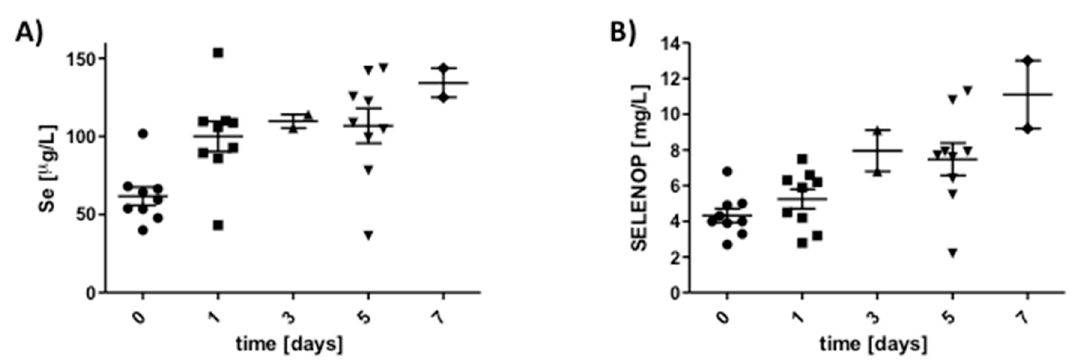
Figure 5. Time-resolved analysis of Se and SELENOP increase upon selenite infusion in cardiac surgery patients enrolled into the SOS-LVAD study. ( A ) Se concentrations increase in most of the cardiac patients undergoing elective heart surgery and selenite infusions (left); patient characteristics not yet de-blinded. ( B ) SELENOP concentrations increase in most of the patients in parallel to Se, partly reaching values of >7 or even >10 mg SELENOP/L after 5 or 7 d of selenite infusion (right).